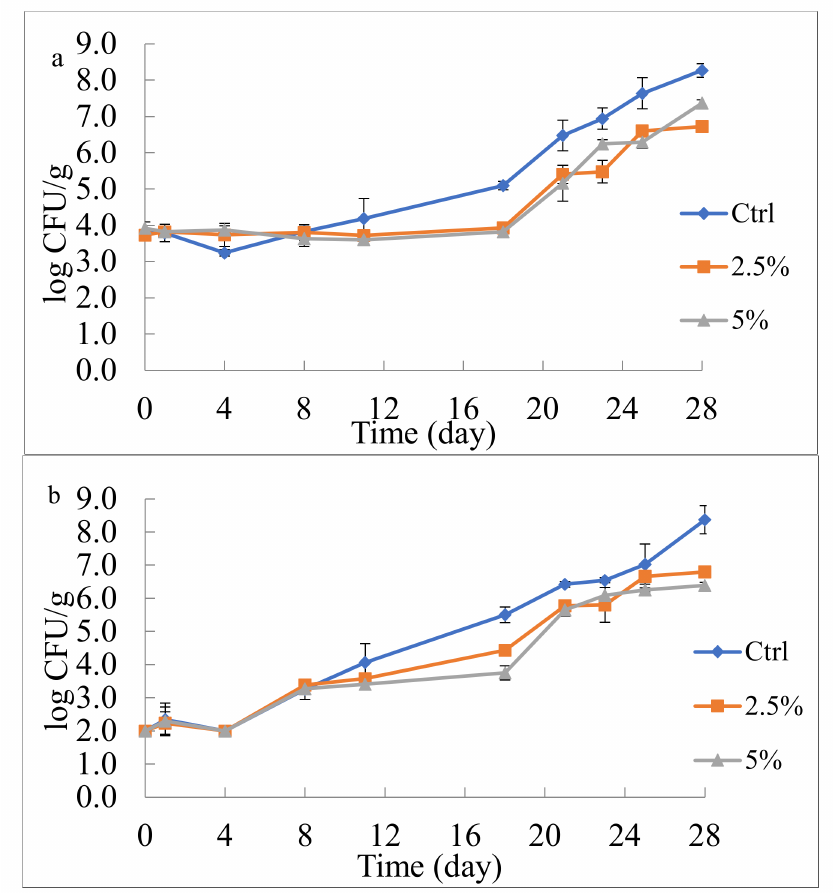
Figure 1. Evolution of total mesophilic ( a ) and psychrotrophic ( b ) bacteria in fruit salad during 28 days of refrigerated storage (5 ◦ C). Ctrl: fruit salad without pomegranate peel powder; 2.5%: fruit salad with 2.5% ( w / v ) pomegranate peel powder; 5%: fruit salad with 5% ( w / v ) pomegranate peel